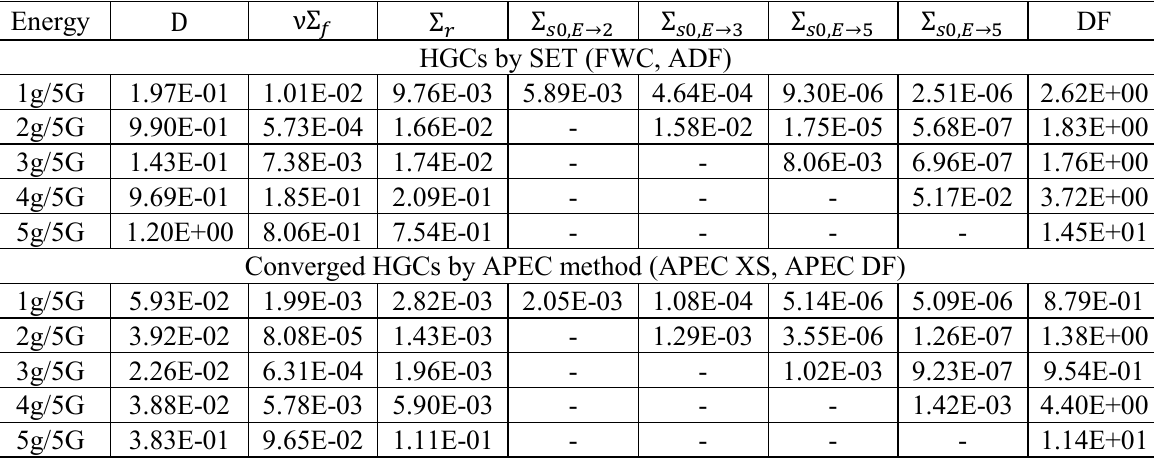
Table Ⅳ . * RMS error of HGCs by SET and APEC